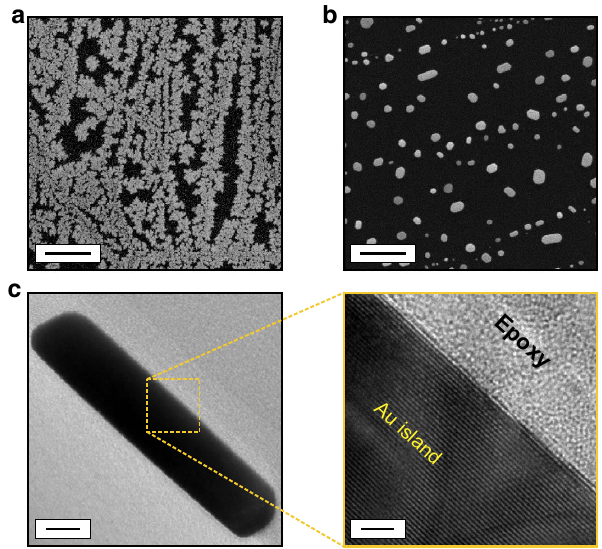
Figure 1 | Structural characterization of gold islands on graphite. ( a ) A representative SEM image of the thin film formed on graphite after thermal deposition of 1Å gold. Scale bar, 500nm. ( b ) An SEM image of the graphite surface decorated with gold islands of various size after post-deposition annealing at 650 (cid:2) C. Scale bar, 500nm. ( c ) Cross-sectional TEM images of an individual gold island. The highlighted high-resolution image confirms the crystalline structure of the gold island, as well as the absence of an oxide layer. Scale bars, 10nm and 2nm,